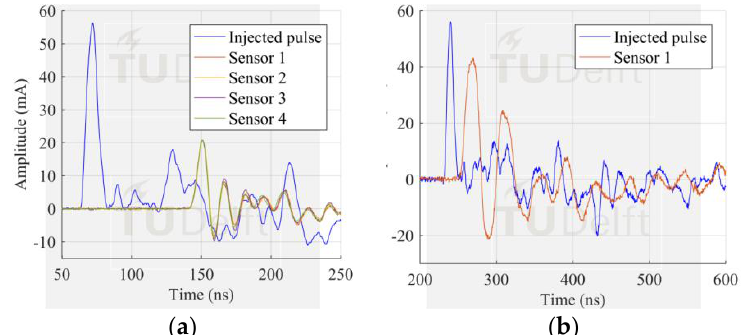
Figure 7. Results with configuration 3, pulse injected at the test cell position ( a ) four sensors installed and no current flowing through the remaining 12 bolts; ( b ) one sensor installed and no current flowing through the remaining 15 bolts.